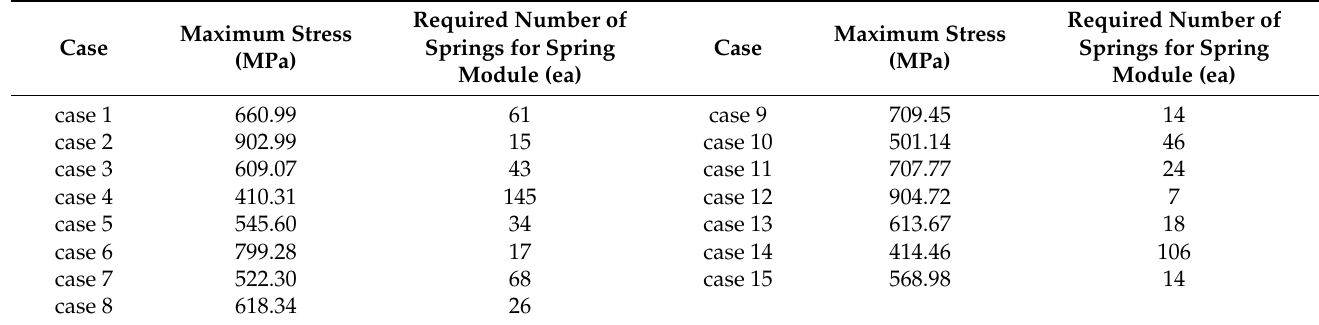
Table 4. Result of CCD Case.